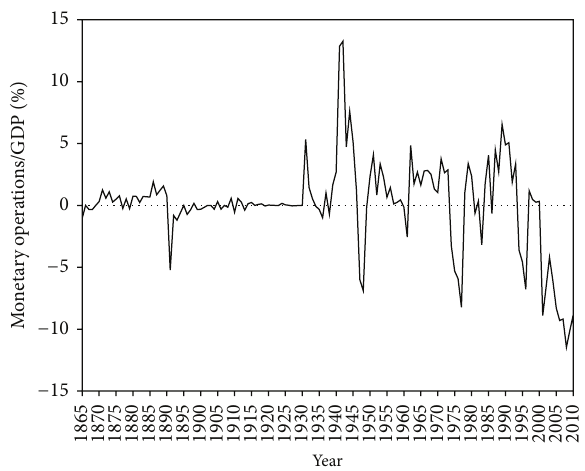
Figure 15: The balance of payments performance: monetary opera- tions/GDP (sources: before 1998 [25]. For the last years [26, 27]).